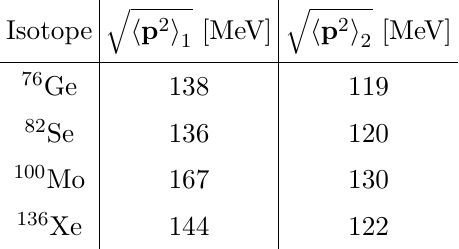
Table 3 . Root mean squares of the neutralino momentum exchange found by inserting the light and heavy scalar and tensor NMEs in table 2 into the formula in eq. (4.13). We show the values for the four relevant isotopes used in this